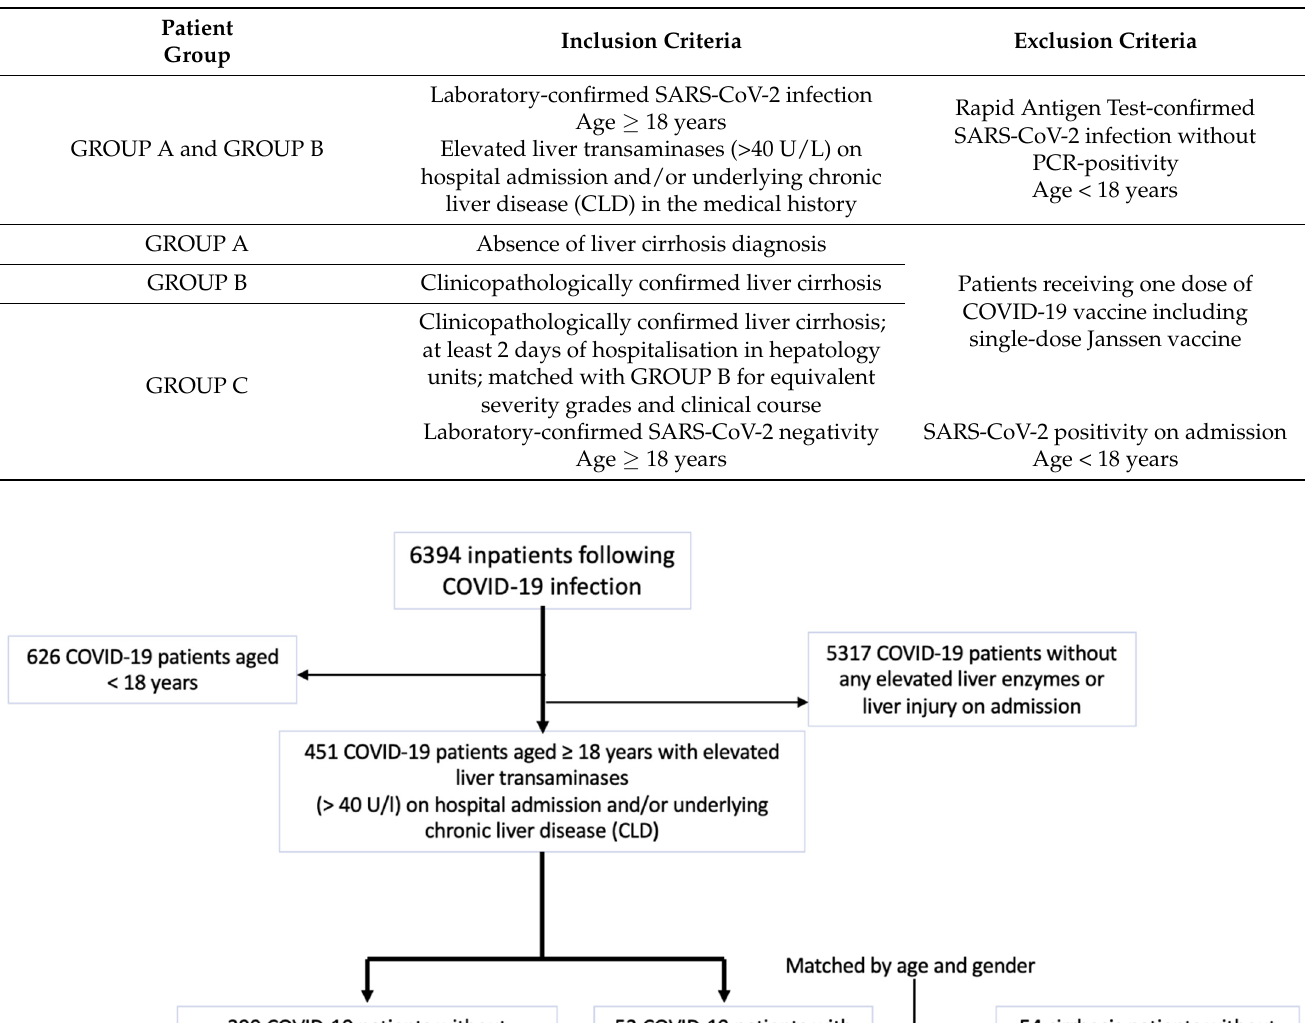
Table 1. Inclusion and exclusion criteria.